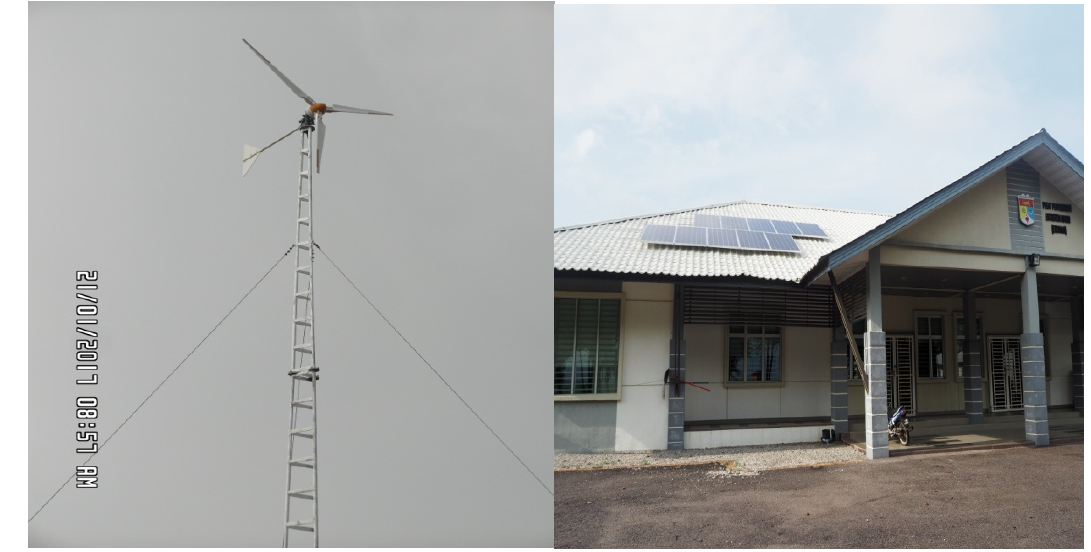
Figure 6. The installed 2 ‐ kW wind turbine and 3 ‐ kW solar photovoltaic panels at EKOMAR. Malaysia is a tropical country with more than 10 h of sunshine a day throughout the year [27].